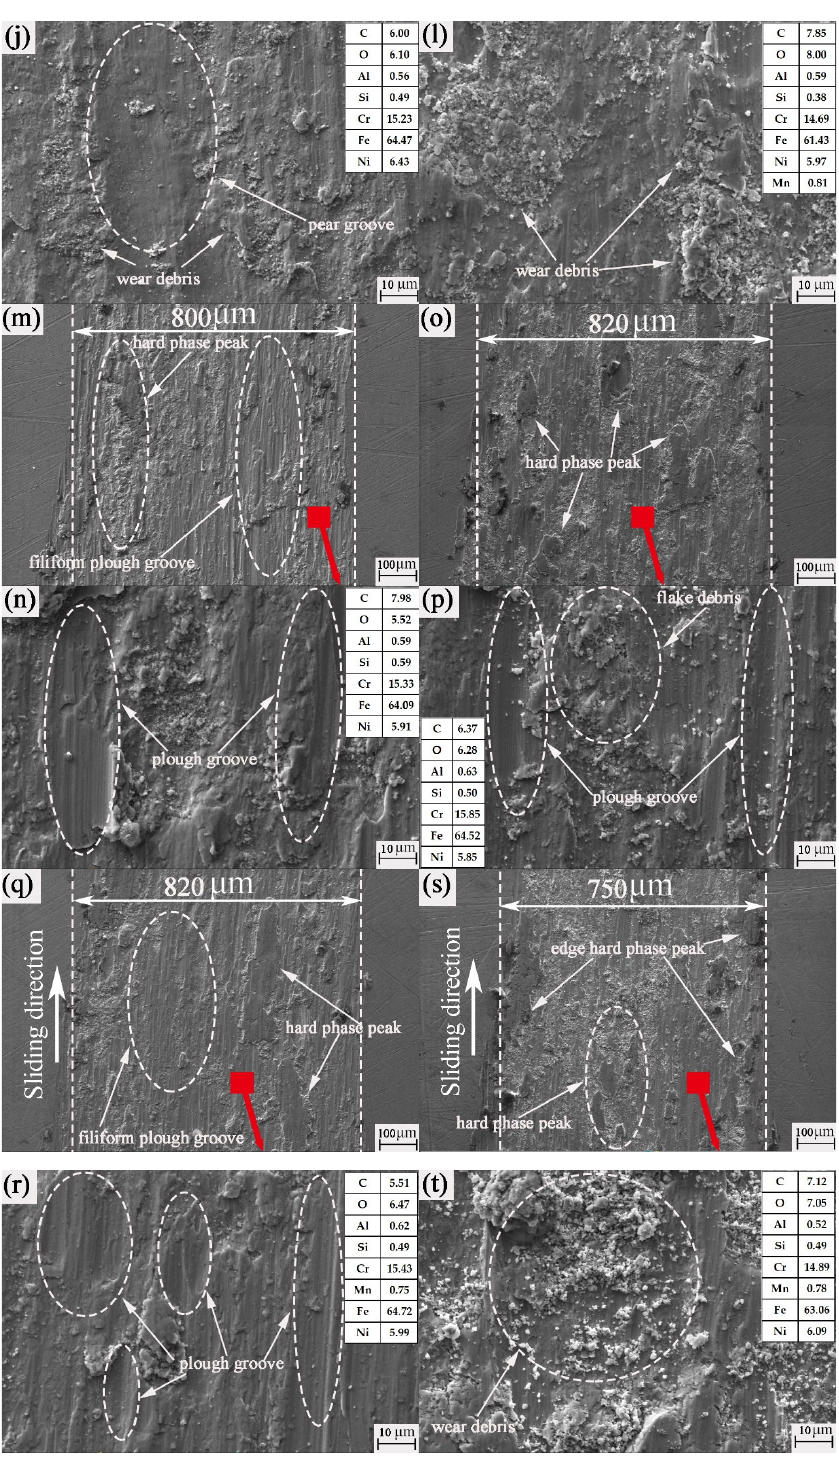
Figure 9. SEM images of the untextured worn plates: ( a,b ) untextured rotation radius of 15 mm; ( c,d ) untextured rotation radius of 22.5 mm; ( e,f ) 0.4 mm groove width mechanical texture rotation radius of 15 mm; ( g,h ) 0.4 mm groove width mechanical texture rotation radius of 22.5 mm; ( i,j ) 0.6 mm groove width mechanical texture rotation radius of 15 mm; ( k,l ) 0.6 mm groove width mechan ‐ ical texture rotation radius of 22.5 mm; ( m,n ) 0.8 mm groove width mechanical texture rotation ra ‐ dius of 15 mm; ( o,p ) 0.8 mm groove width mechanical texture rotation radius of 22.5 mm; ( q,r ) 1.0 mm groove width mechanical texture rotation radius of 15 mm; ( s,t ) 1.0 mm groove width mechan ‐ ical texture rotation radius of 22.5 mm.